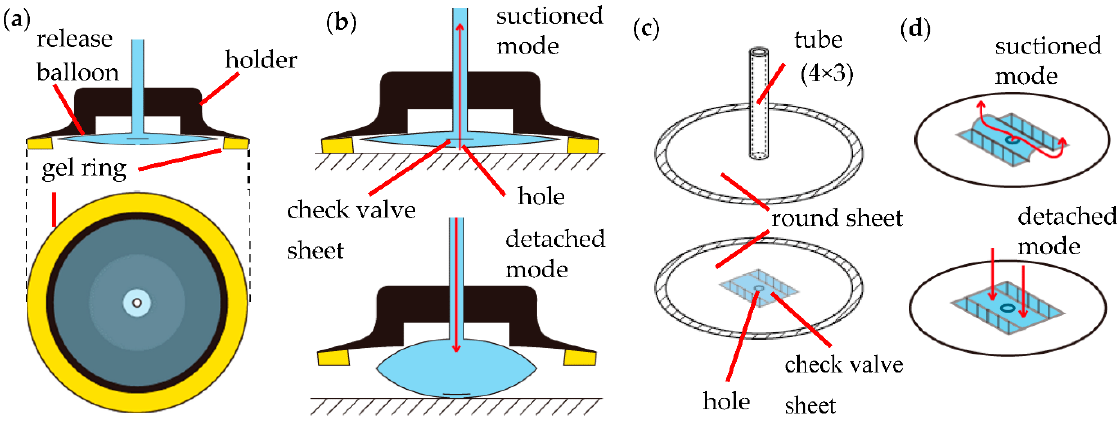
Figure 1. Configuration and operating principle of the proposed hybrid suction cup (HS cup): ( a ) Side and bottom view of HS Cup; ( b ) working principle of two different modes; ( c ) configuration of the release balloon; ( d ) operating principle of the check valve sheet.